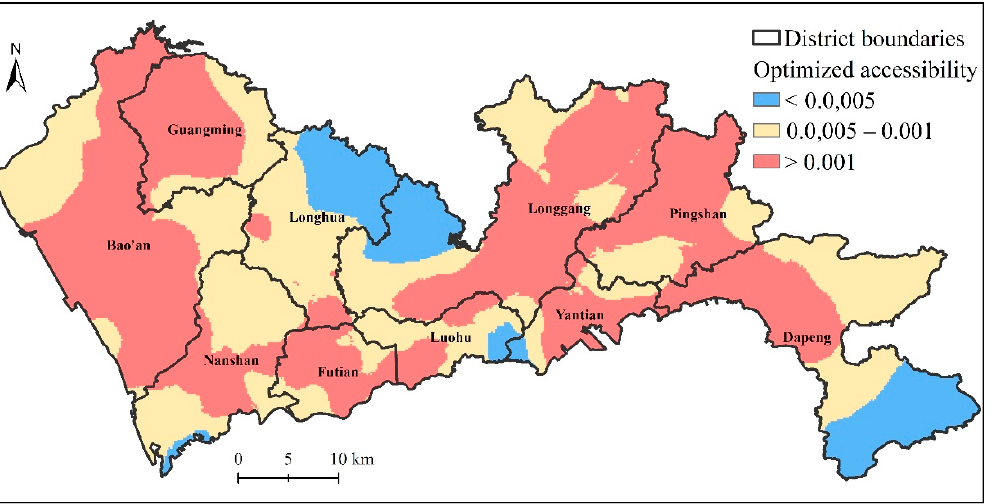
Figure 8. The distribution of optimized accessibility to tertiary healthcare facilities.